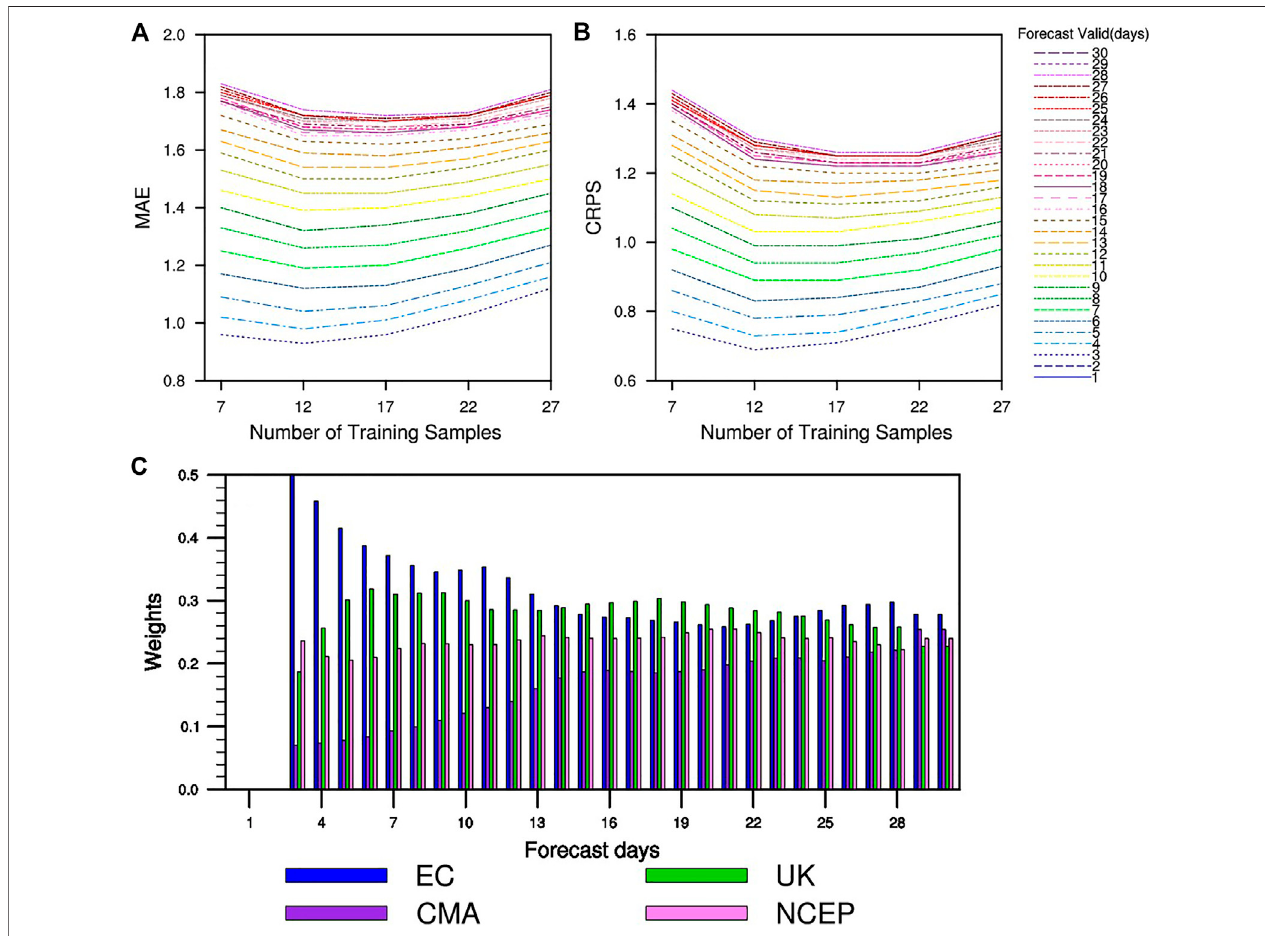
FIGURE 7 | The MAE (A) and CRPS (B) of BMA as a function of the number of samples used for BMA training. The different patterns of lines indicate different forecast valid days. The average weights (C) of four individual ensemble members were used for BMA when using 20 sliding samples.